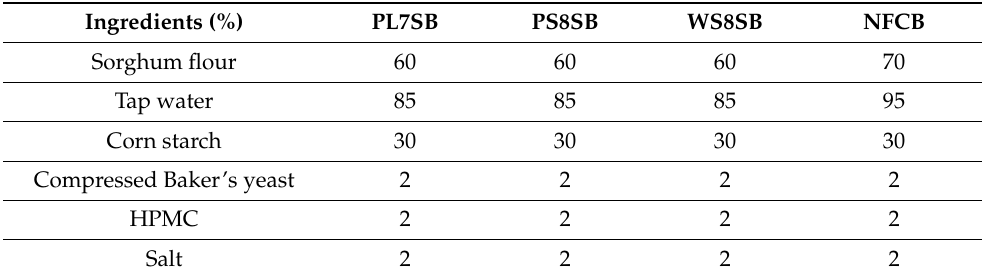
Table 2. Formulas for bread